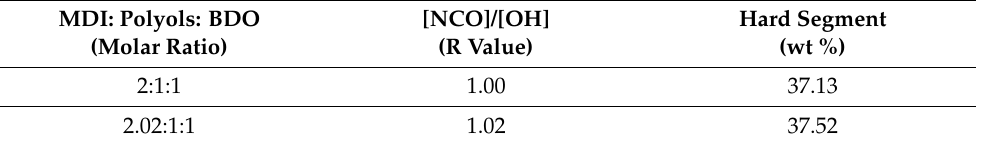
Table 2. Formula structures and [NCO]/[OH] ratios of thermoplastic